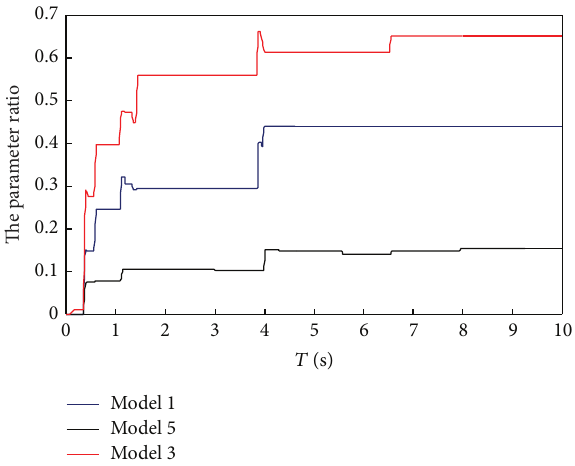
Figure 36: The tension crack damage parameter of spandrel under Lixian County ground motion.